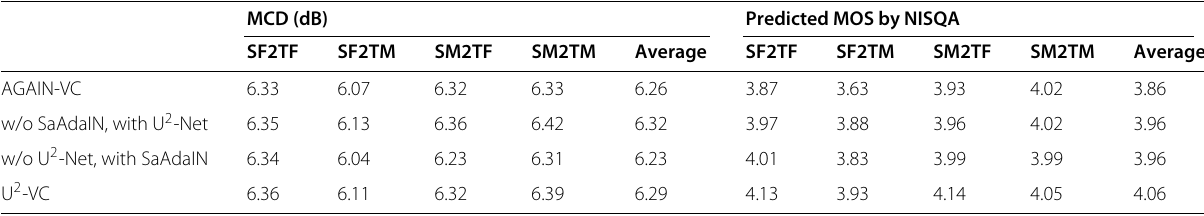
Table 2 Objective evaluation results of the ablation study on architecture in seen-to-seen conversion scenario. “AGAIN-VC” represents the network has neither U 2 -Net structure nor SaAdaIN. “U 2 -VC” represents the network has both U 2 -Net structure and SaAdaIN